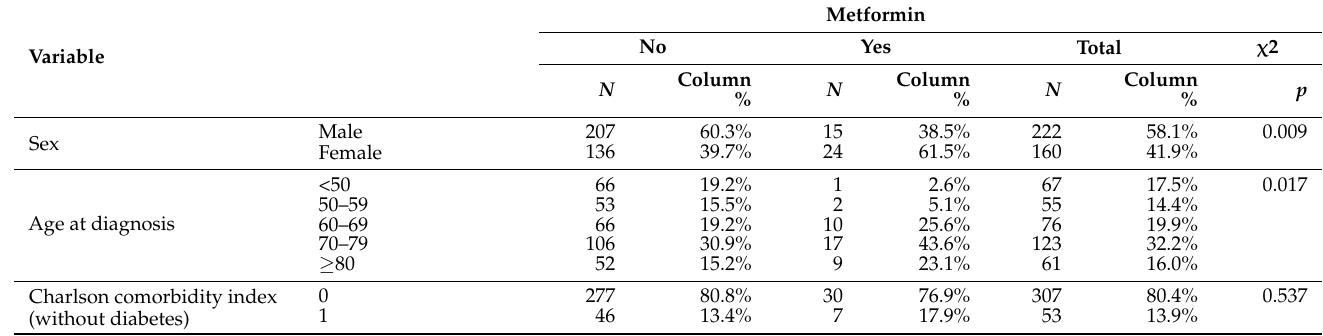
Table 2. Patients clinico-pathological characteristics according to metformin use ( n =